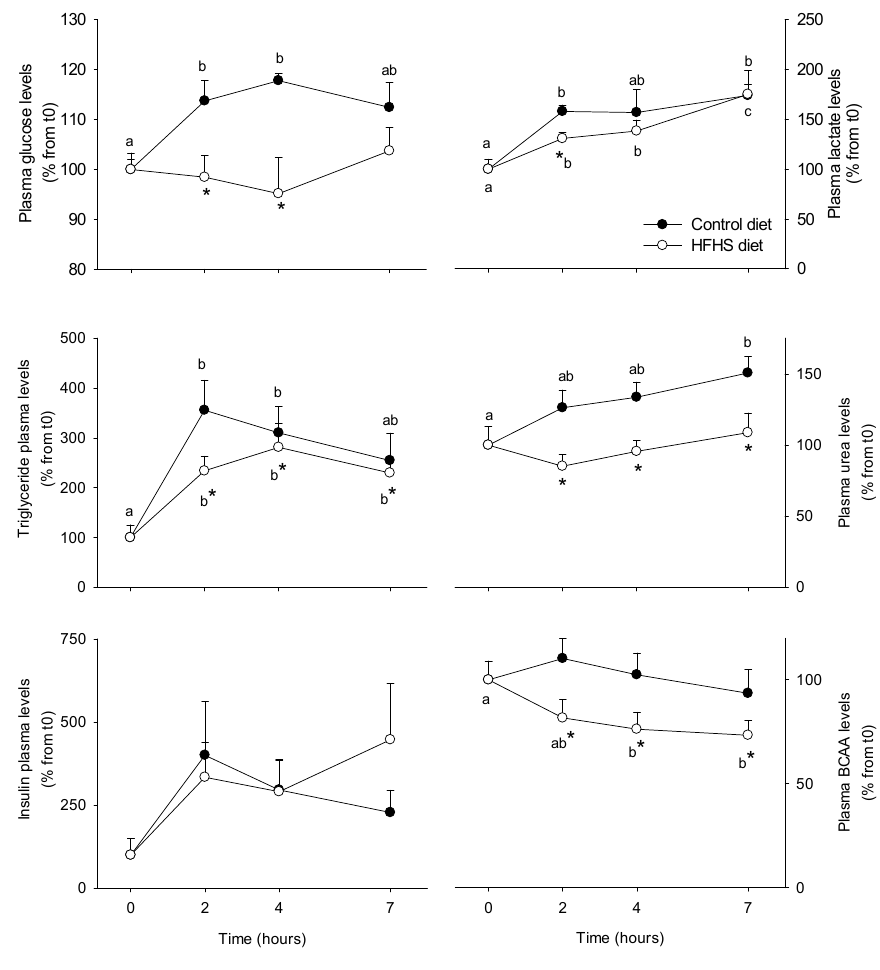
Figure 1. Plasma parameters in Yucatan mini-pigs fed either a control or a high fat–high sucrose (HFHS) test meals. Results are expressed as means + SEM ( n = 5) and were analysed using a repeated measures 2-way ANOVA test. Different letters indicate significant differences between sampling points for a given meal test. * Significant different for a given sampling point between the control and the HFHS meals ( p < 0.05). BCAA: branched-chain amino acids.